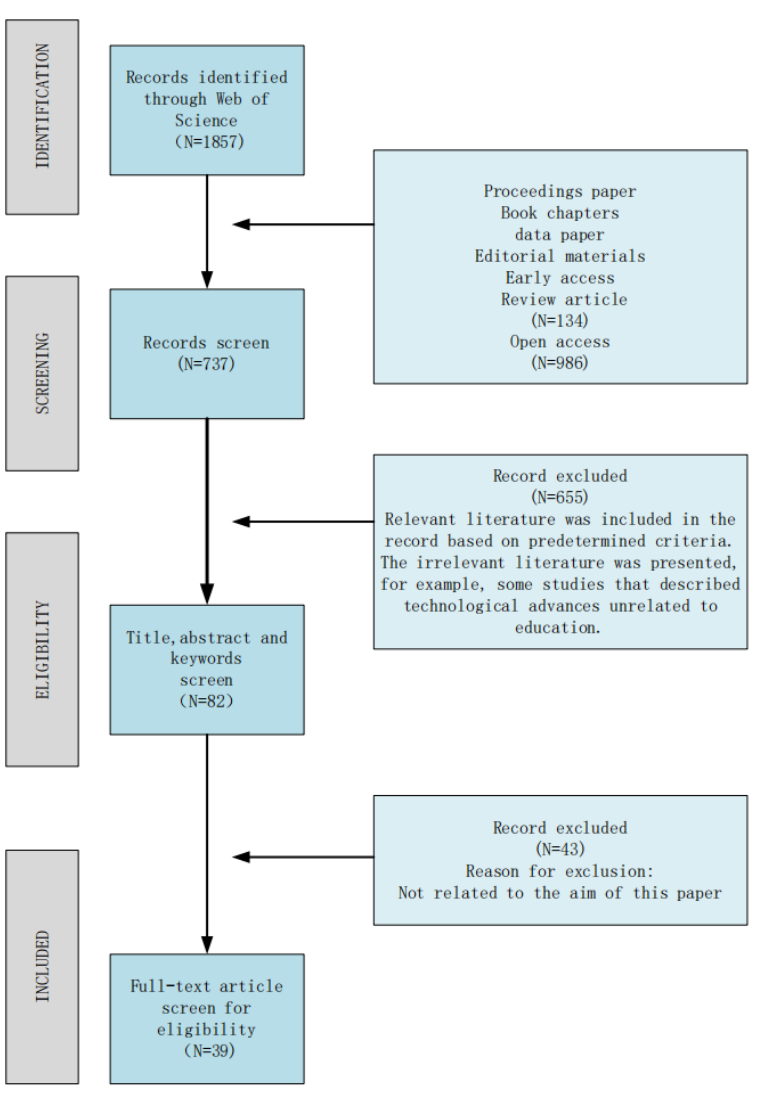
Figure 3. The flow chart of the whole review